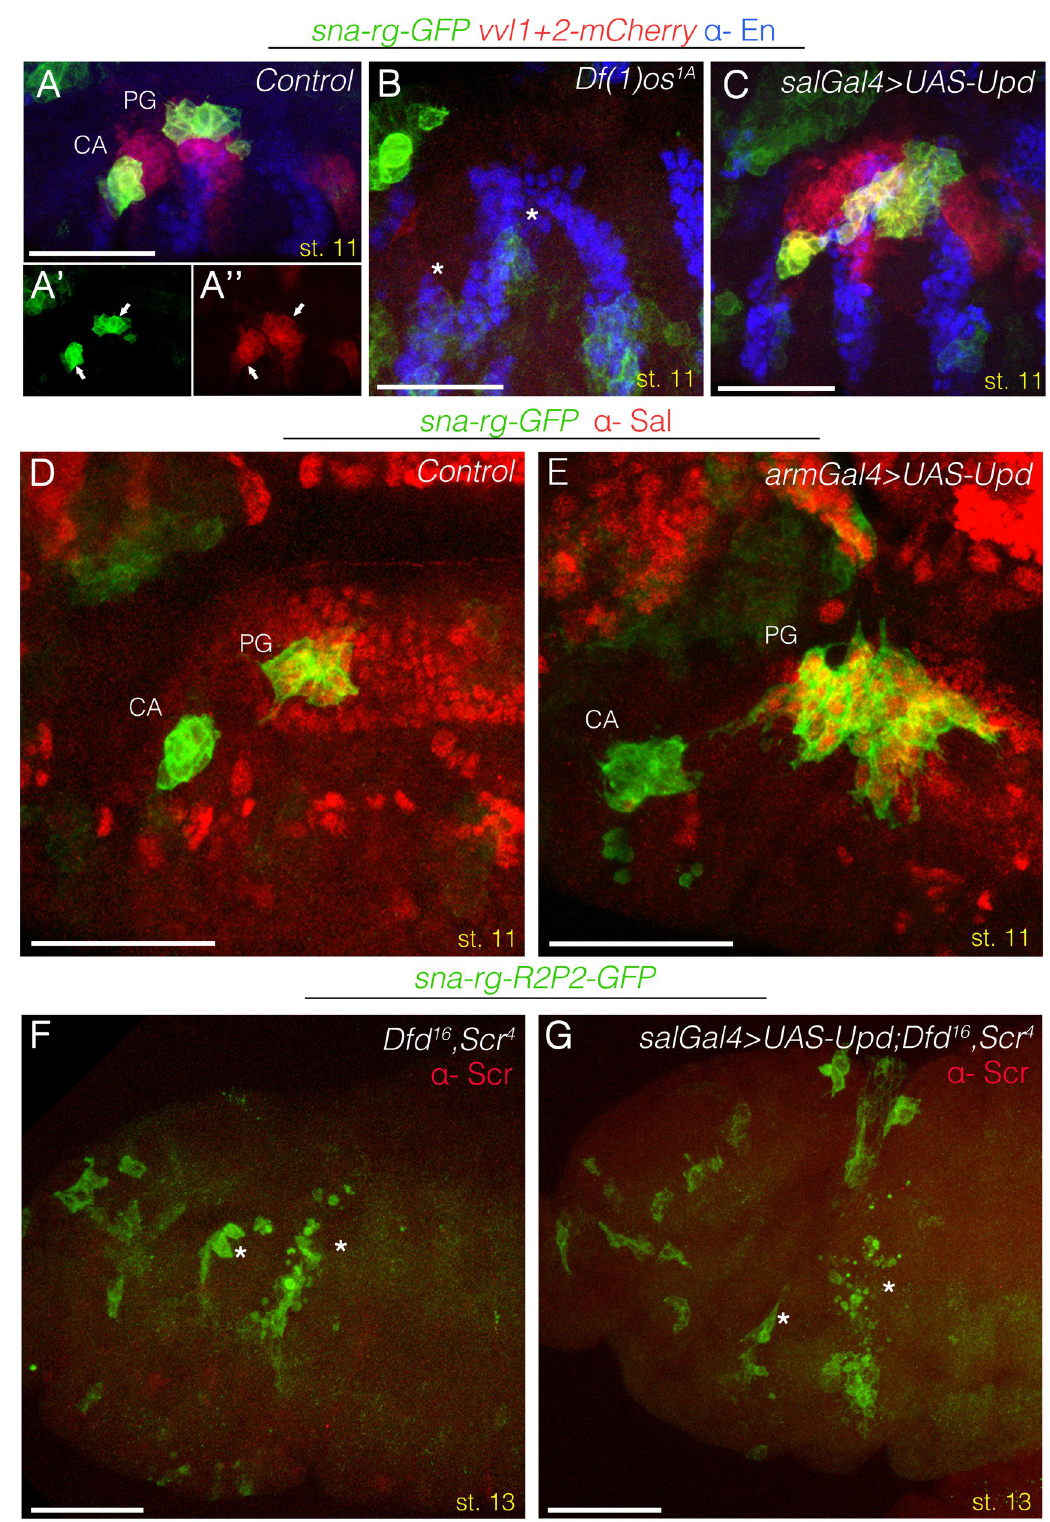
Fig 5. Epistatic relationship between JAK/STAT, Wnt, Hh and Hox inputs over sna-rg regulation. (A-C) Embryos expressing sna-rg-GFP (green) and vvl1+2-mCherry (red) stained with anti-En (blue). (A) sna-rg and vvl1+2 expression in st11